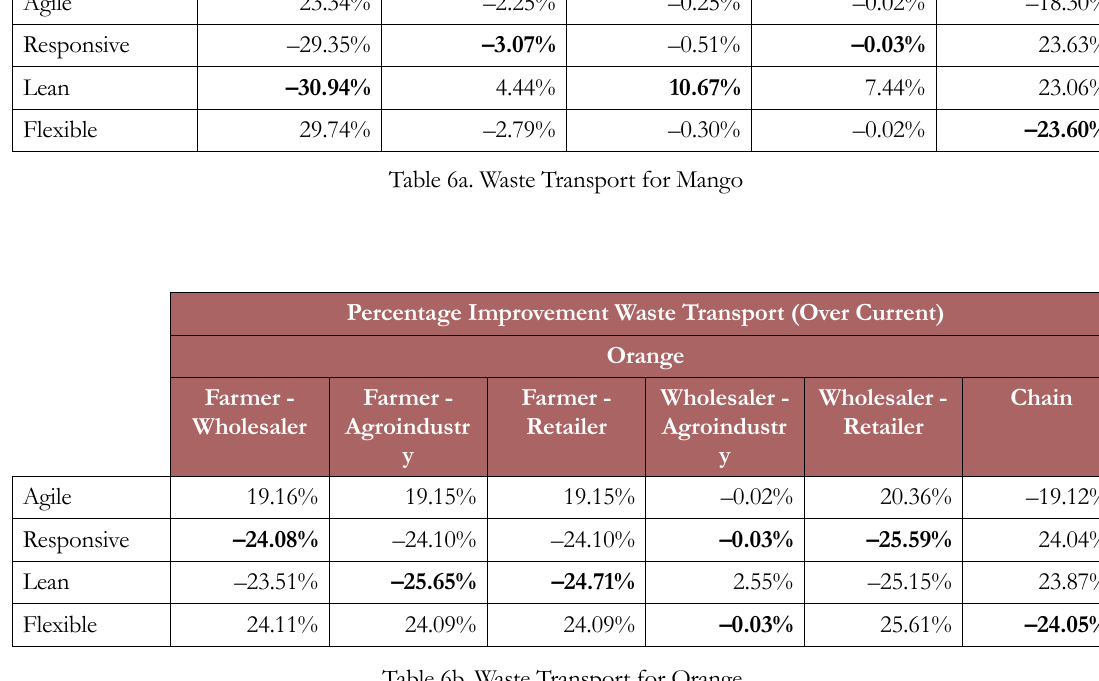
Table 6b. Waste Transport for Orange